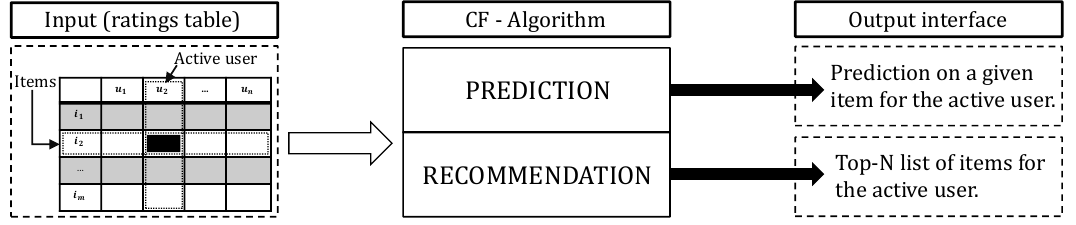
Figure 1. The Collaborative Filtering